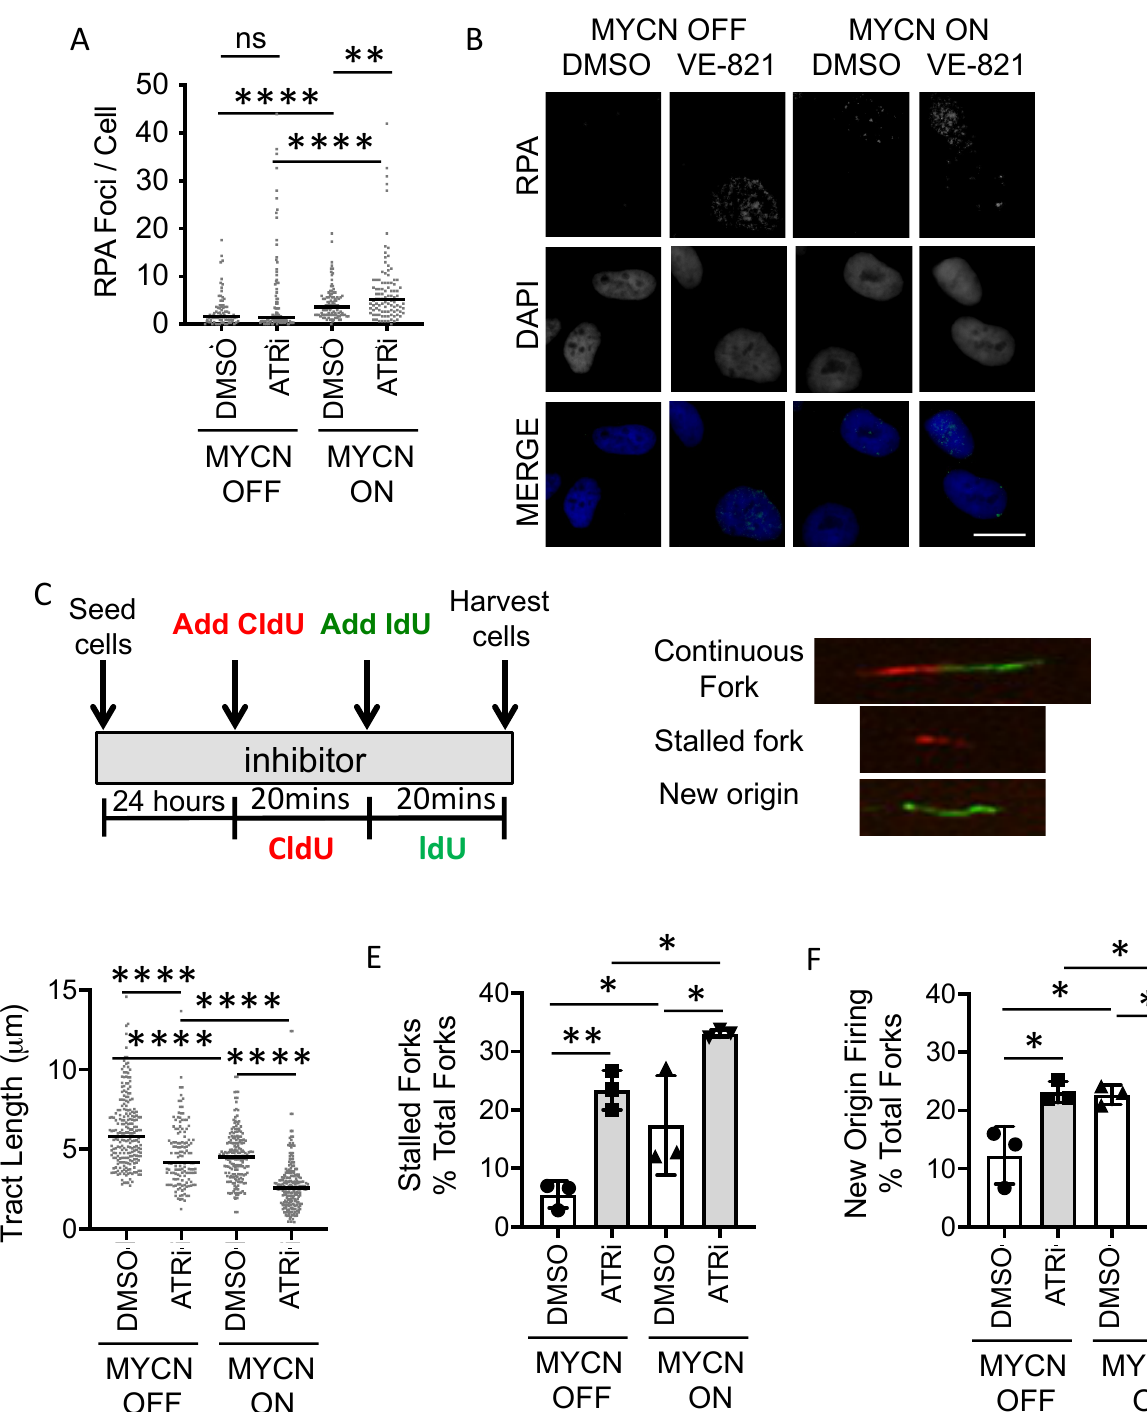
Figure 2. MYCN expression perturbs replication forks in NB cells and this is exacerbated upon ATR inhibition. ( A ) Number of RPA foci/cell in SHEP-Tet21/N cells with MYCN ON or MYCN OFF 24 h post treatment with 0.5 µ M VE-821 or DMSO control. Data are pooled from three independent repeats for each repeat n > 50 cells, lines indicate median value, independent repeats are shown in Supplementary Figure S1. ( B ) Example RPA images. Scale bar = 10 µ m ( C ) DNA fibre analysis of replication fork speed and stalling in VE-821 treated SHEP-Tet21/N cells with MYCN ON and MYCN OFF. Cells were incubated in 0.5 µ M VE-821 or DMSO control and then pulse labelled with CldU, for 20 min, and label switched to IdU for 20 min. Example images of replication forks are shown. ( D ) DNA fibre length ( µ m) (CIdU). ( E ) Percentage fork stalling, calculated as a % of CIdU only labelled tracts (red) from continuous forks (CIdU (red) and IdU (green) labelled tracts)